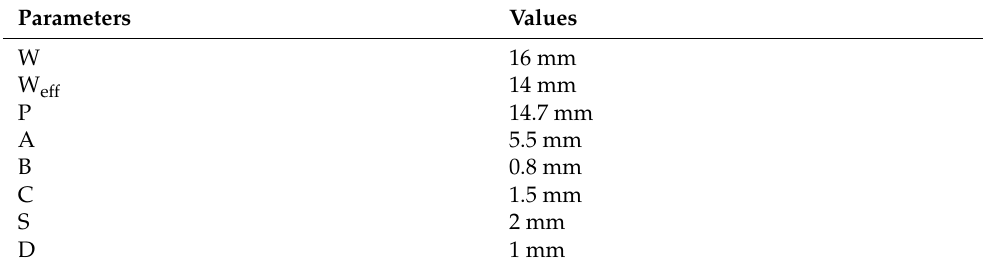
Table 1. Parameters for unit cell.